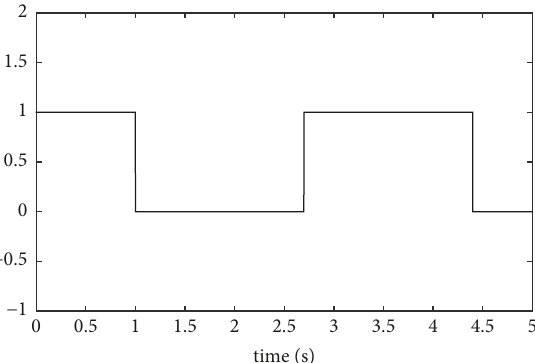
Figure 2: Switching signal of system (1) with